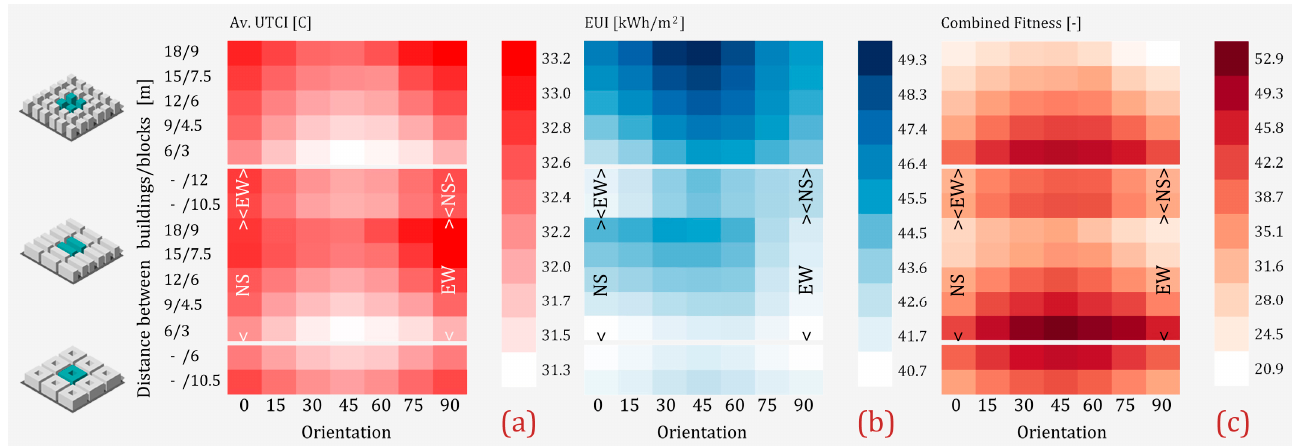
Figure 6. Distances between buildings/blocks on the East–West axis across different orientations (shown as deviation from starting position) plotted against the performance indicators, ( a ) AV.UTCI, ( b ) EUI, and ( c ) combined fitness. A single EW distance comprises the average of all other North–South distances.